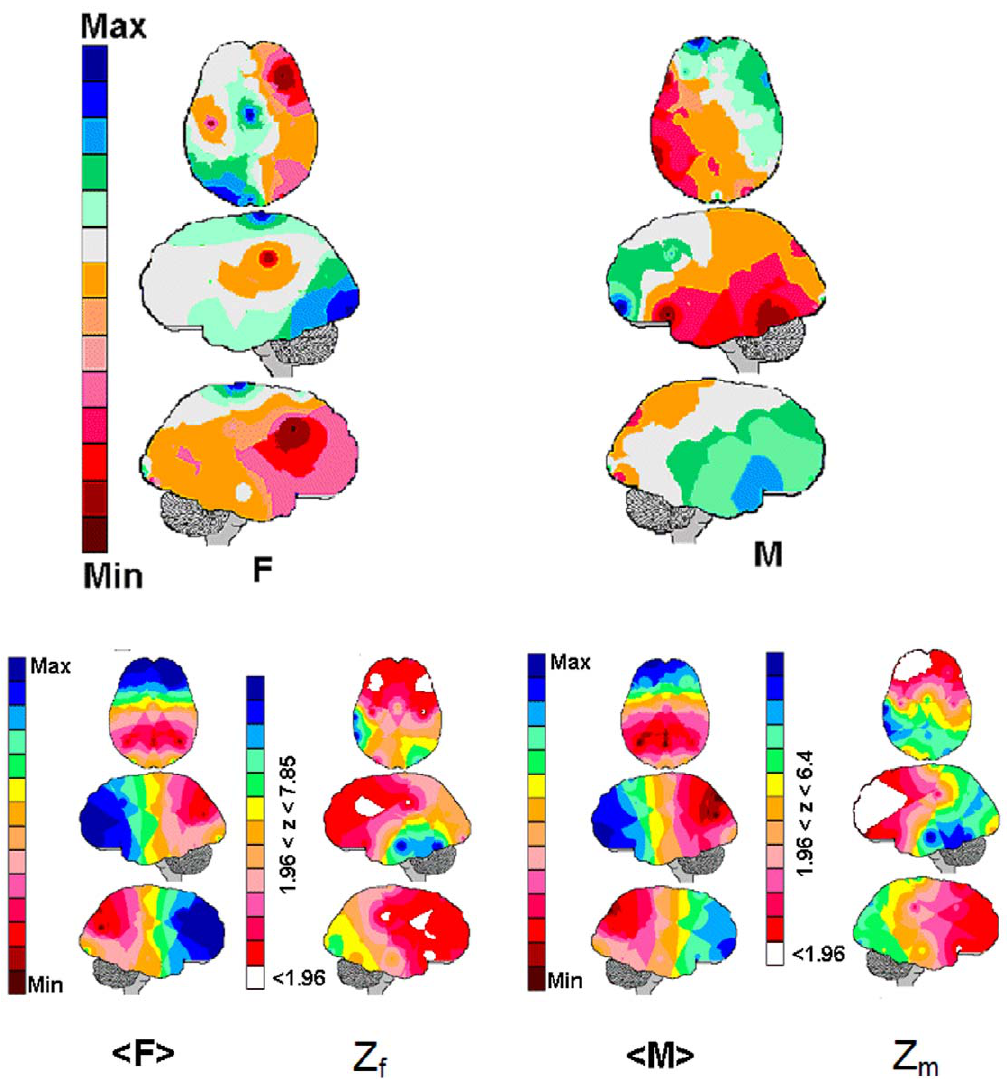
Figure 2. The EEG mappings for the calculated linear regression. IQ ~ a z b 1 h e 1 ð Þ z ::: z b 20 h e 20 ð Þ calculated for females (F) and males (M) Legends as in Figure 1. The Pearson’s correlation coefficient between the regression mappings F and M was 2 0.27. The Z mappings Z f and Z m mappings show the differences between the averaging mappings , F . and , M . and the Hypothetical brain H in figure 4. The areas for which the Z-score is smaller than 1.96 are shown in white, and the areas for the Z-score is greater than 1.96 are collored according to the magnitude of the Z- score.